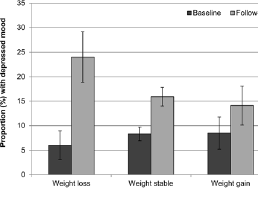
Figure 1. Prevalence of depressed mood at baseline and follow-up by weight change status. Values are mutually adjusted for age, sex, wealth, and weight loss intention. Error bars represent the 95% confidence